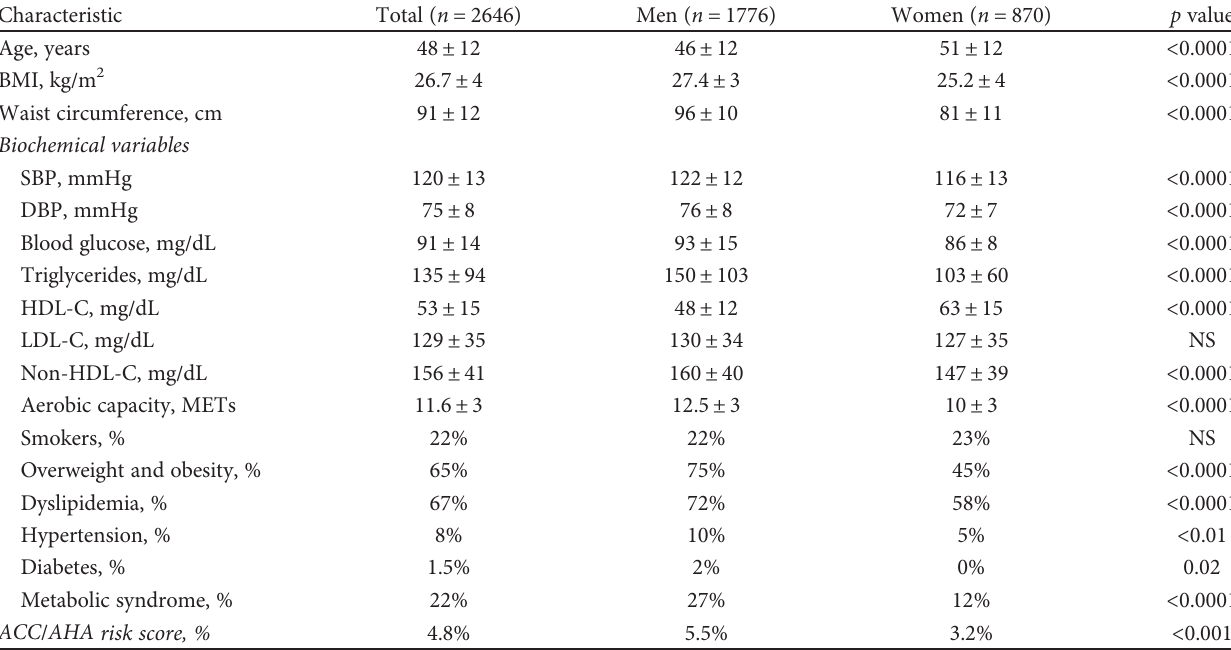
Table 1: Demographics and characteristics of the study